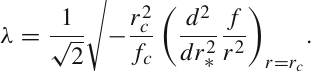
Fig. 8 Effective potentials for the scalar type of gravitational pertur- bations (cid:11) = 2 for α = − 3 (with a negative gap) and α = − 2 (positive definite); M = 1 / 2